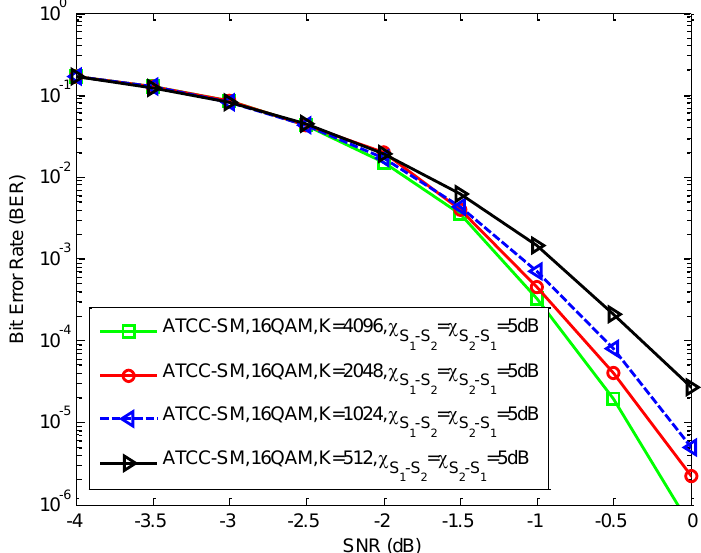
Figure 14. BER performance of two-source ATCC-SM based on the CMI under a non-ideal inter-user channel scenario over the slow Rayleigh fading channel, 16QAM, N r = N t = 8 , and different information lengths such as K = 512, 1024, 2048 and 4096.